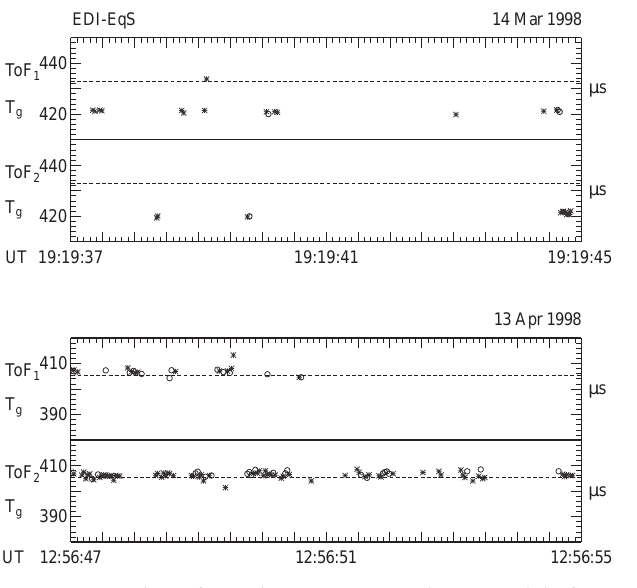
Fig. 2. Comparison of gyro-time measurements by EDI and the flux- gate magnetometer MAM for 8-s periods on 14 March 1998 ( top ) and for 13 April 1998 ( bottom ). The discrepancy of (cid:25) 12 l s between the time-of-flight measurements from EDI ( asterisks and circles ) and the gyrotime T g computed from the field strength measured by MAM ( dashed line ) on 14 March can be attributed to a 3.1 nT spin-axis o(cid:128)set in the MAM data. The data for 13 April 1998 demonstrate good agreement (to within about 2 l s or 0.5 % ) after the 3.1 nT o(cid:128)set had been incorporated in the on-board computation